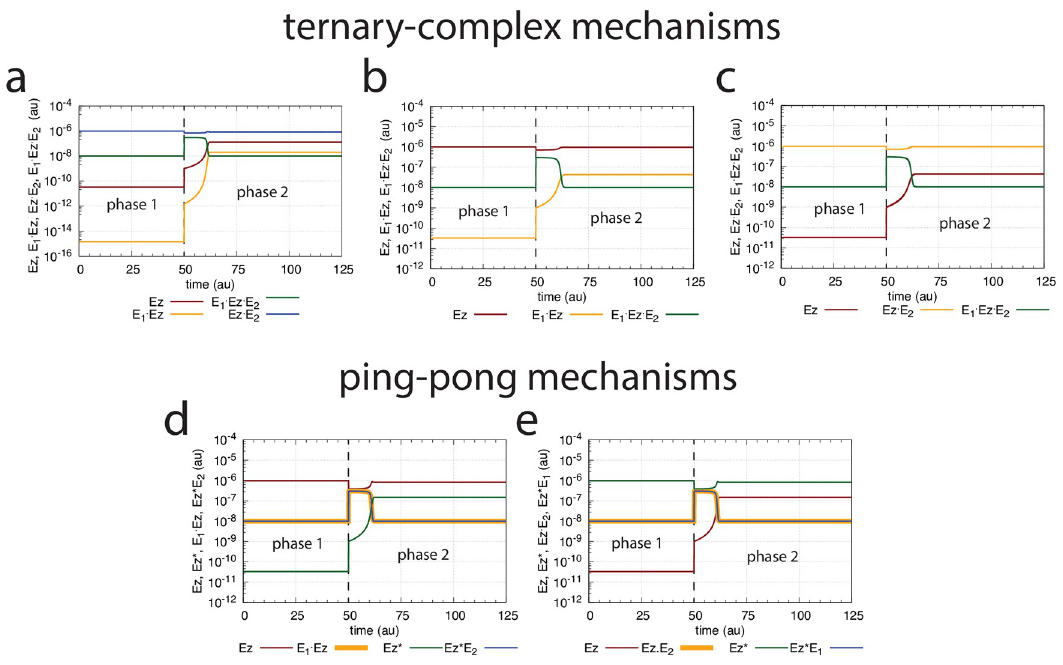
Fig 28. Enzyme species profiles of the m4 ternary-complex (Figs 19 and 24) and ping-pong mechanisms (Fig 27) when k 2 =10 in phase 1, and k 2 =2 × 10 4 in phase 2. (a) random-order ternary-complex mechanism, (b) compulsory-order ternary-complex mechanism with E 1 binding first to Ez , (c) compulsory-order ternary-complex mechanism with E 2 binding first to Ez , (d) ping-pong mechanism with E 1 binding first to Ez , (e) ping-pong mechanism with E 2 binding first to Ez . Rate constants (if applicable) are as in Fig 20. Initial concentrations: (a) A 0 =3.0, E 1,0 =1.0 × 10 − 2 , E 2,0 =3.0 × 10 2 , Ez 0 =3.3 × 10 − 11 , (E 1 � Ez) 0 =1.4 × 10 − 15 , (E 1 � Ez � E 2 ) 0 =1.0 × 10 − 8 , (EzE 2 ) 0 =9.9 × 10 − 7 . (b) A 0 =3.0, E 1,0 =1.0 × 10 − 2 , E 2,0 =3.0 × 10 2 , Ez 0 =9.9 × 10 − 7 , (E 1 � Ez) 0 =3.3 × 10 − 11 ,